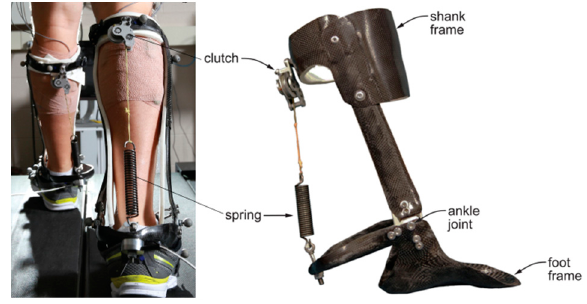
Figure 10. Device for reducing human metabolic energy during walking [112].